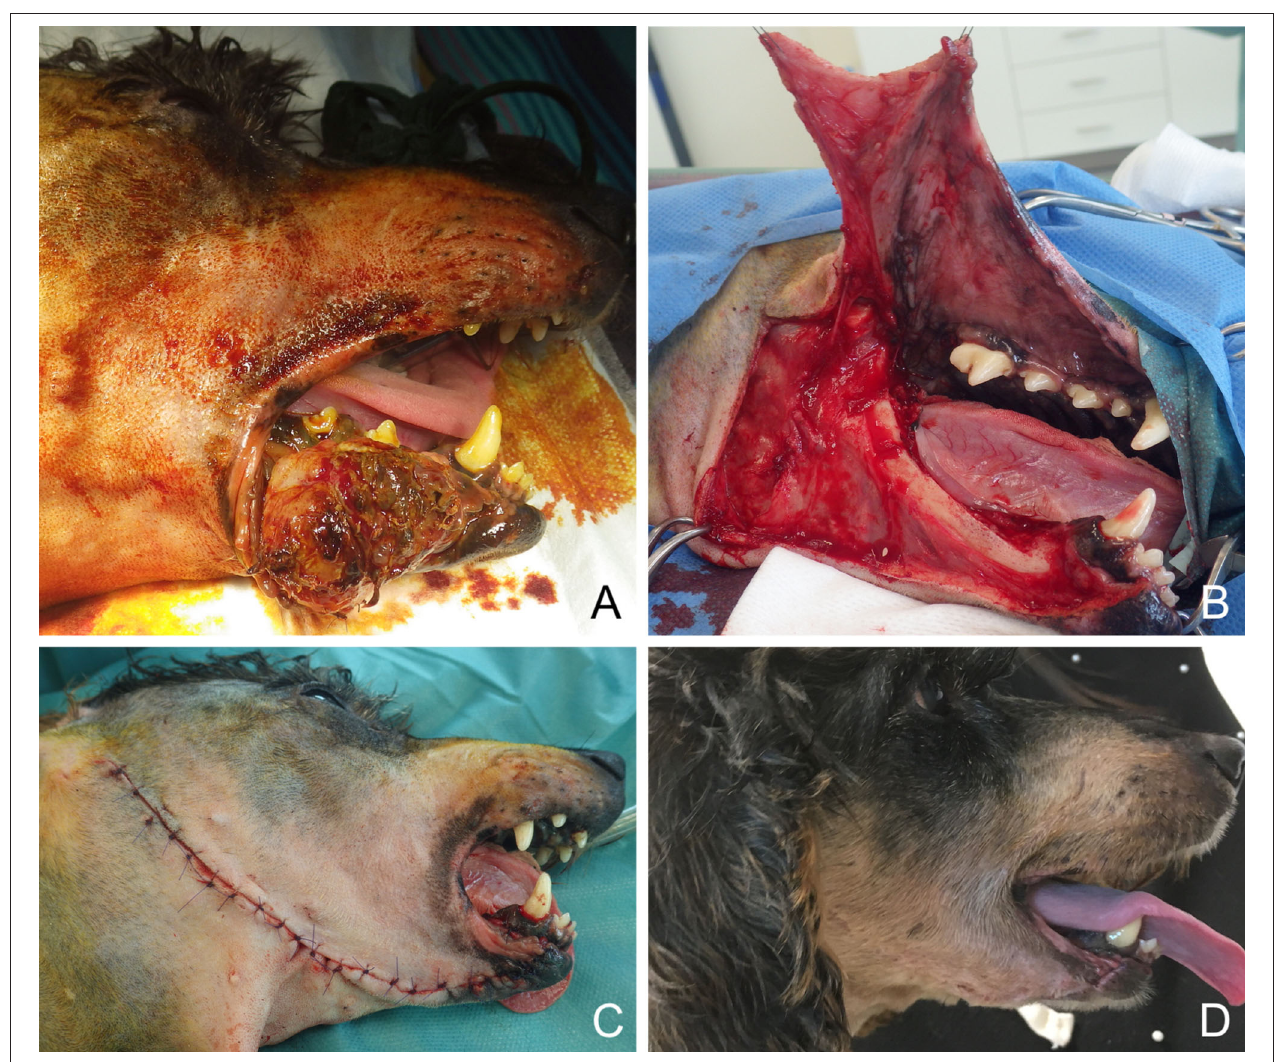
FIGURE 8 | Full-thickness local rotation flap for closure of a lower lip defect in a dog. (A) Oral malignant melanoma of the lower rostral lip. (B) Harvesting of the flap. (C) Immediate postoperative appearance. (D) 6-months postoperative